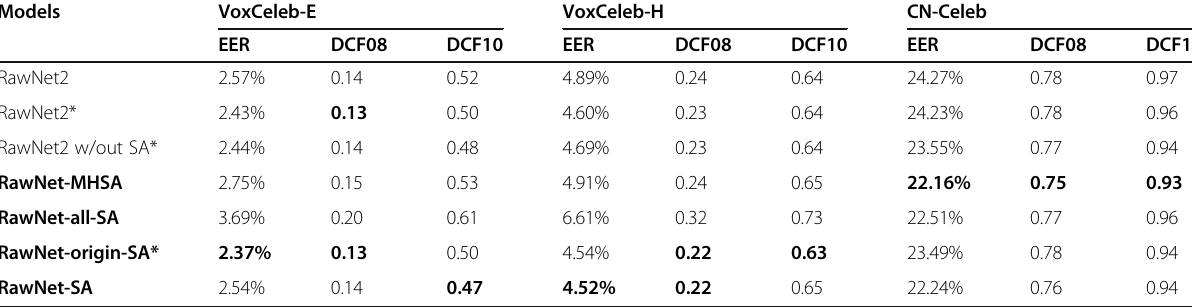
Table 4 The role of self-attention mechanisms on the recognition performance Models